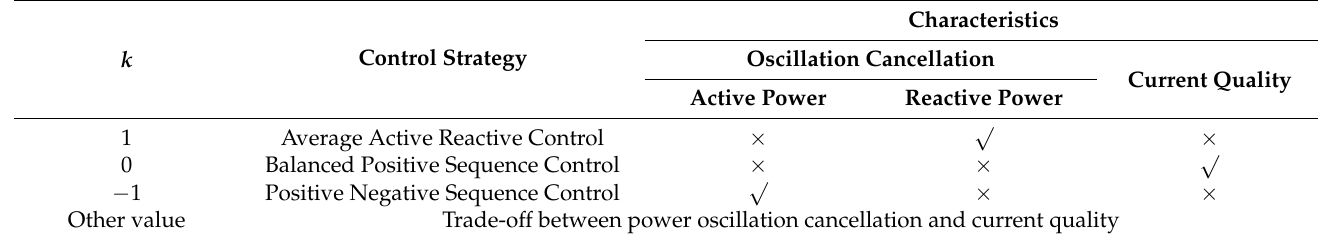
Table 1. Output effect under different adjustment coefficient k